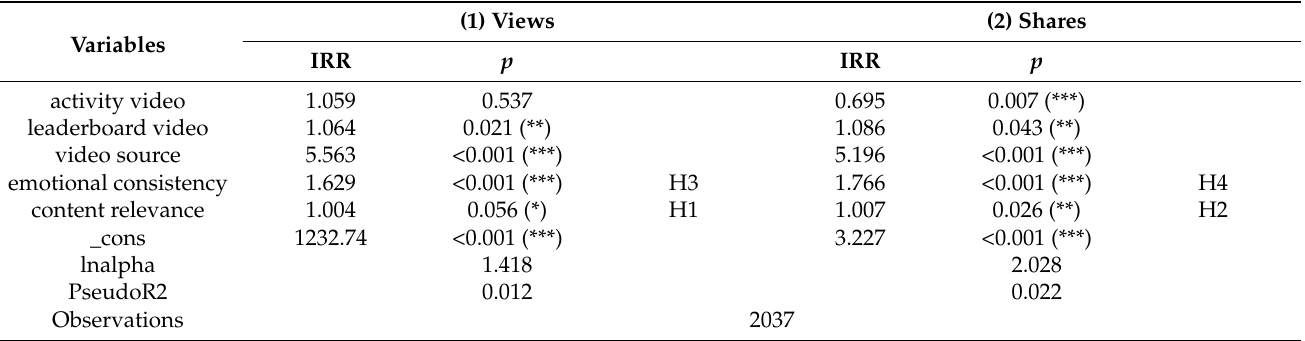
Table 6. Robustness